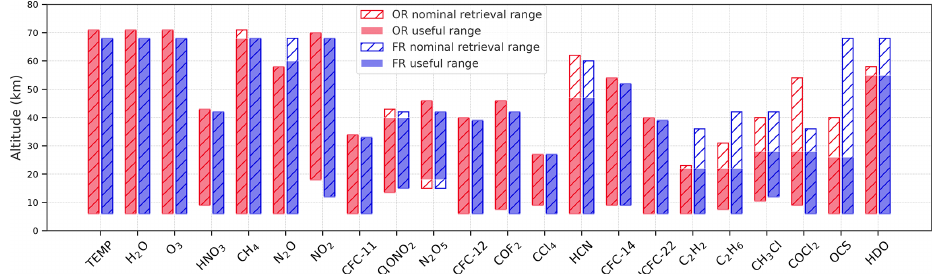
Figure 8. Retrieval range (open boxes) and useful range (shaded area) for all the molecules included in the level2-v8 database. Red indicates the OR period and blue the FR